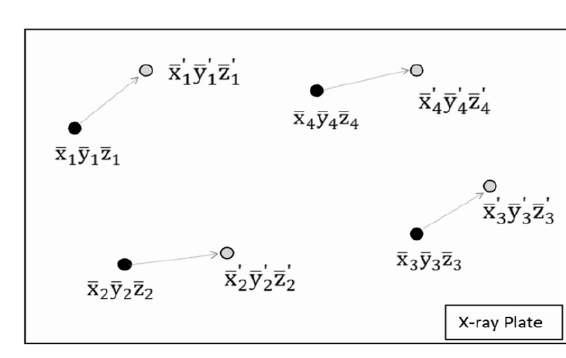
Figure 15. Markers Projections before and after motion.